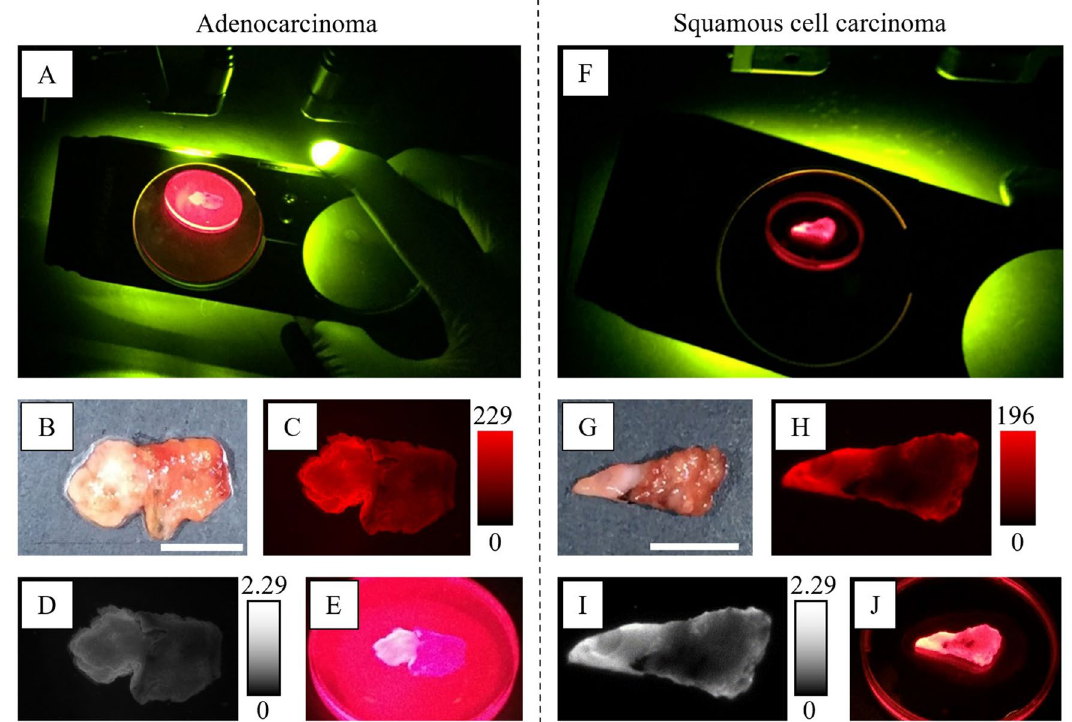
Figure 4. Borderline specimens measured with Maestro and a digital camera ( A–E ; adenocarcinoma (#13), F–J ; squamous cell carcinoma (#24)). ( A,F) QA-2OMeSiR was applied to a sample with a border between tumor and normal areas. The sample was photographed with an iPhone 6 under excitation after 30 min. ( B,G) Image taken under white light before probe addition. The scale bar represents 1.0 cm. ( C,H) Pseudo-color image (600–850 nm) of the specimen 10 min after probe addition. ( D,I) Fluorescence image (640 nm) of a specimen at 10 min after probe addition. ( E,J) Magnified image of a specimen taken at close range through a filter at 30 min after probe addition. Note: digital camera images have not been